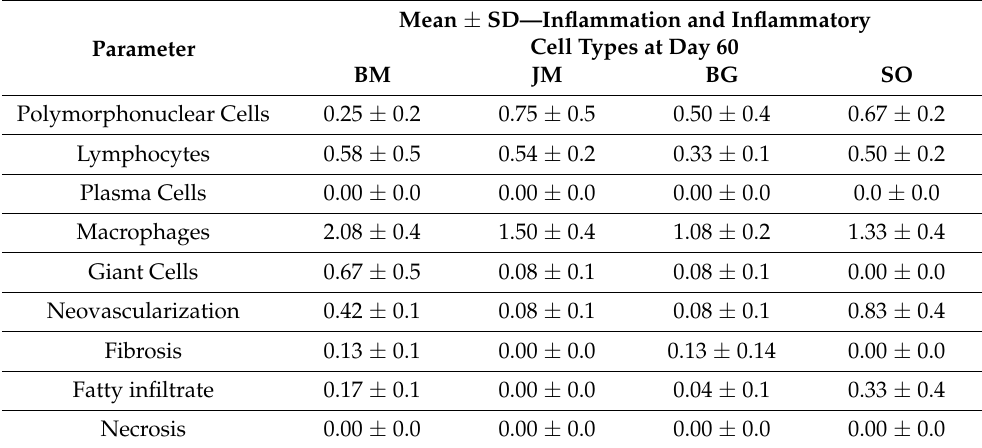
Table 6. Results of the biomaterial scoring evaluation at 60 days post implantationem. BM: bovine- based membrane, BG: Bio-Gide ® membrane, JM: Jason ® membrane, and SO: sham